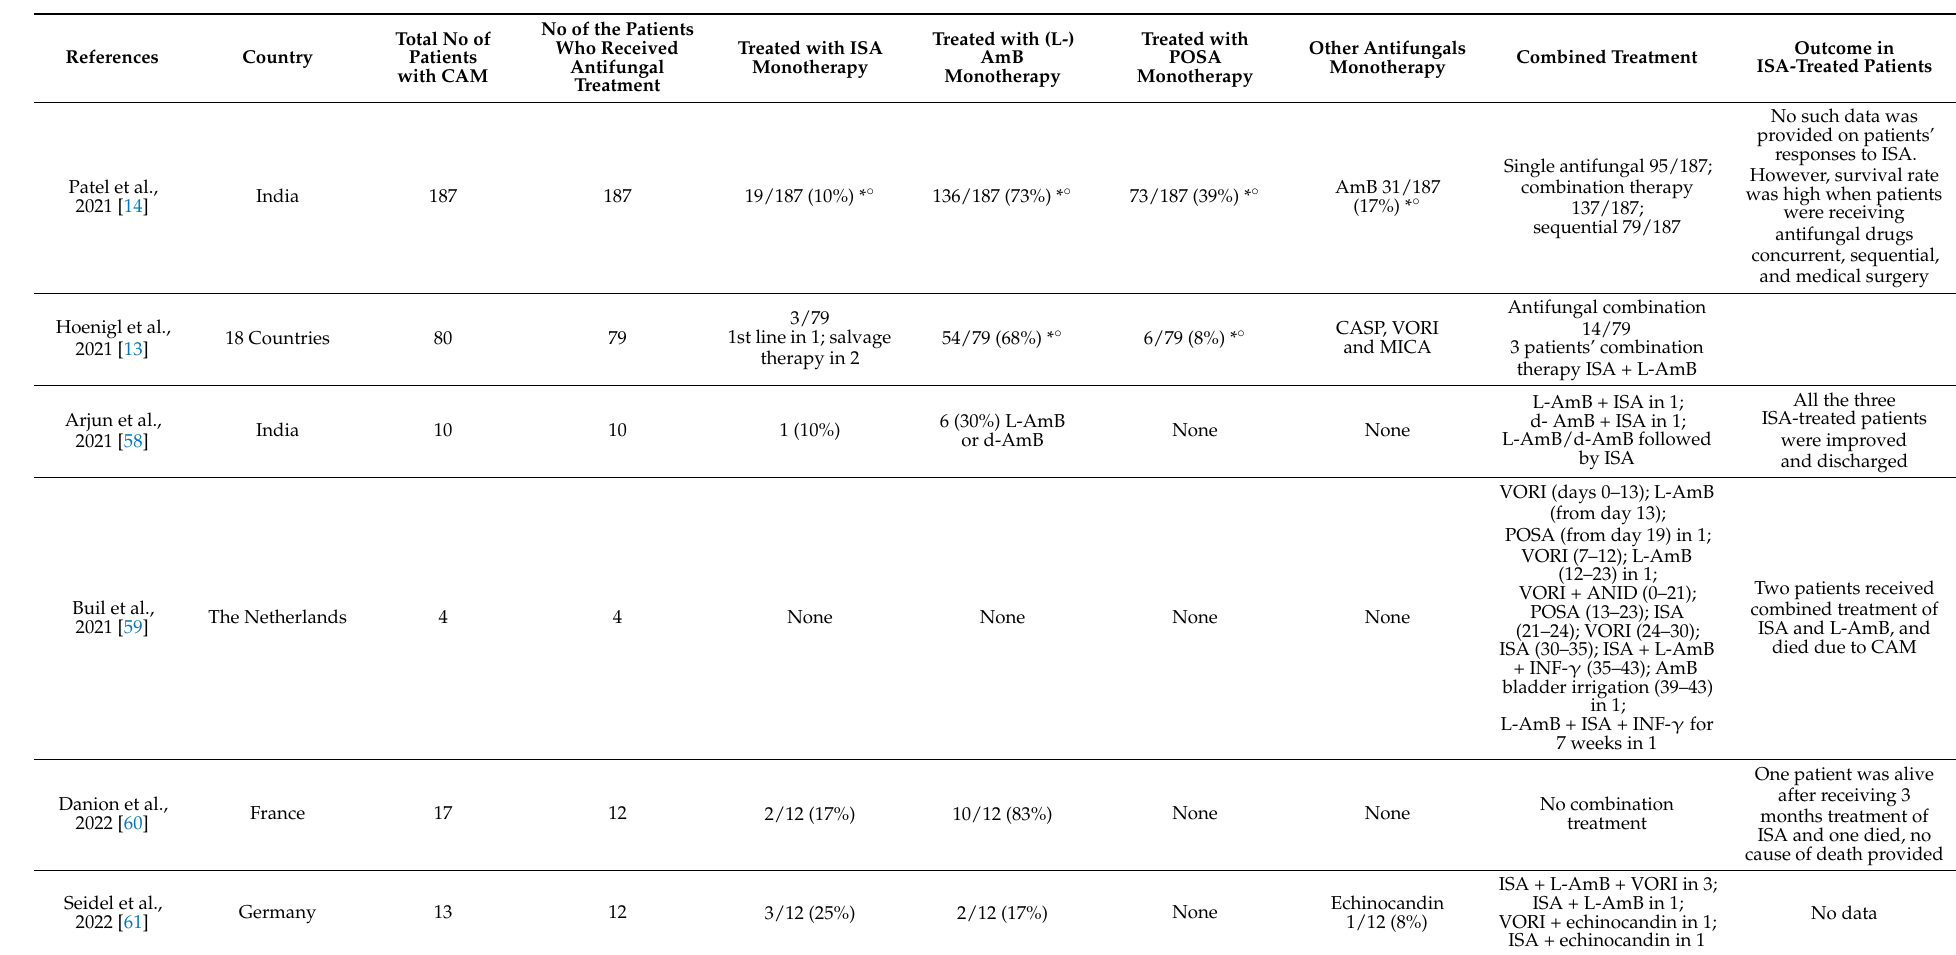
Table 3. Studies reporting patients with CAM in whom isavuconazole treatment was